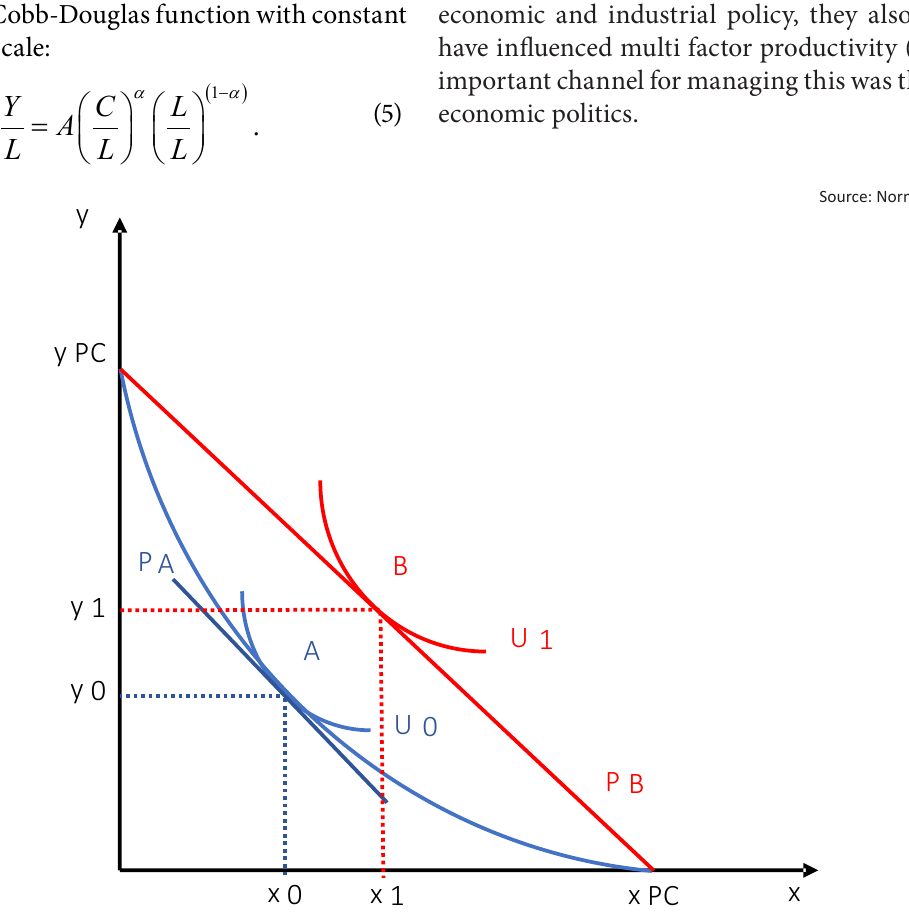
Figure 1. Production and consumption in two countries, with and without